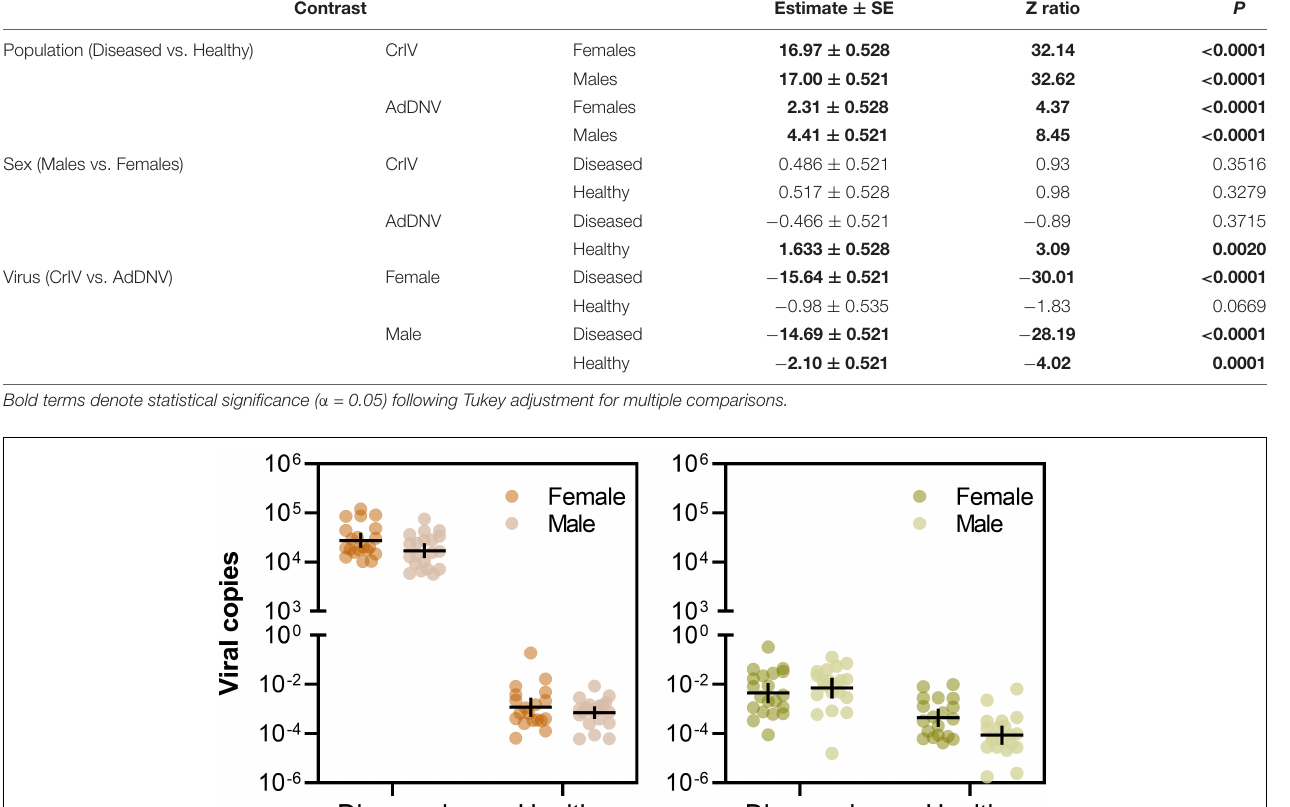
TABLE 4 | Post hoc comparisons of interactions from generalized linear models for log-transformed normalized number of viral copies of cricket iridovirus (CrIV) and Acheta domesticus densovirus (AdDNV) detected across two populations (“Healthy” and “Diseased”) of male and female adult reared Gryllodes sigillatus . Contrast Estimate ± SE Z ratio P Population (Diseased vs. Healthy)